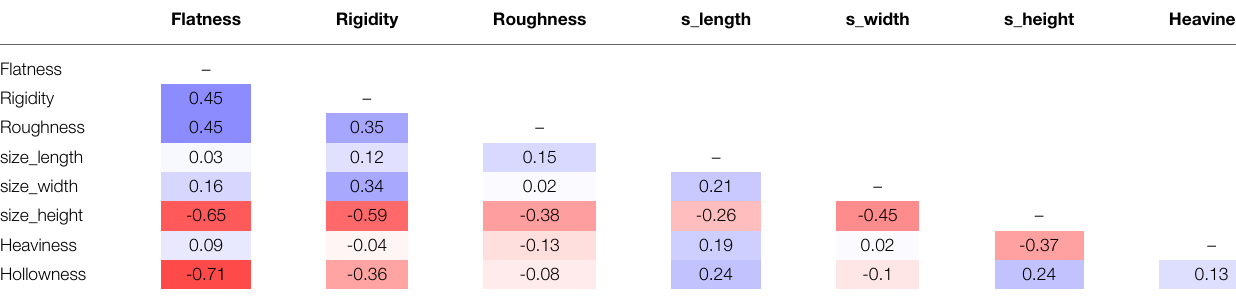
TABLE 3 | Pearson Correlation on the mean values of physical properties. Flatness Rigidity Roughness s_length s_width s_height